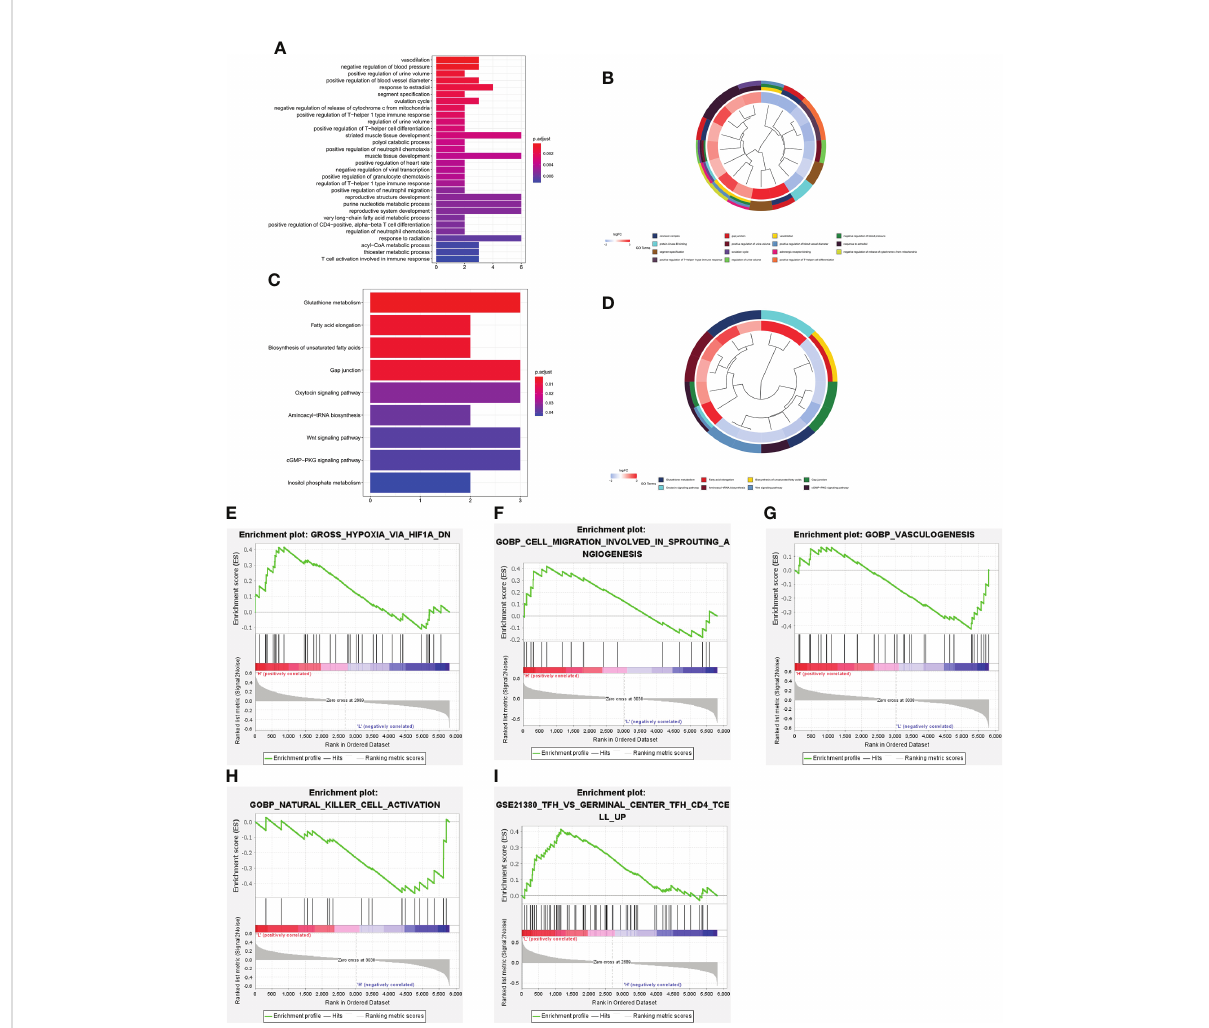
FIGURE 6 Functional enrichment analysis of the DEGs between the high-risk and low-risk groups. Bar plot (A) and circle plot (B) of the top 30 GO pathway analysis enrichment results. Bar plot (C) and circle plot (D) of KEGG pathway analysis enrichment results. (E – I) GSEA between the high- risk and low-risk